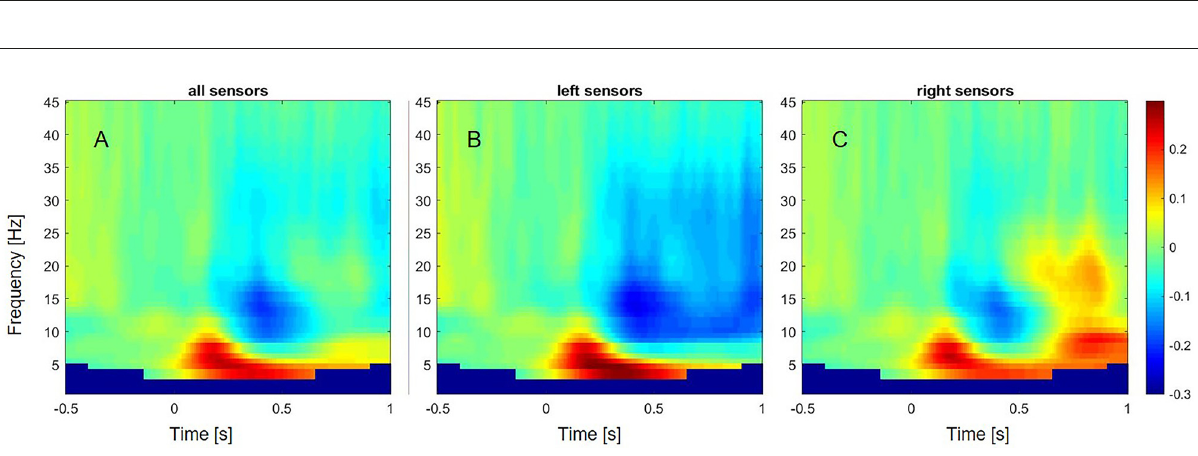
FIGURE2 Event-related changes in oscillations across subjects and different frequency bands from 1 to 45 Hz. (A) Event-related oscillatory changes over all sensors. (B) Event-related oscillatory changes over left sensors. (C) Event-related oscillatory changes over right sensors.